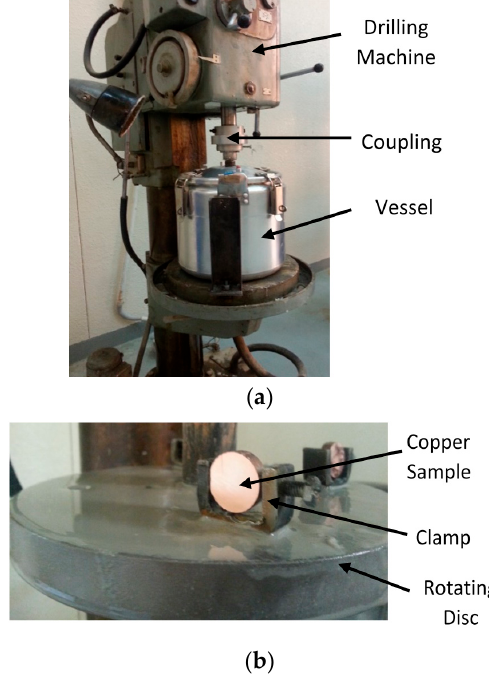
Figure 2. Setup of E-C test by slurry pot method; ( a ) Setup assembly; ( b ) Copper samples clamped to rotating disc.